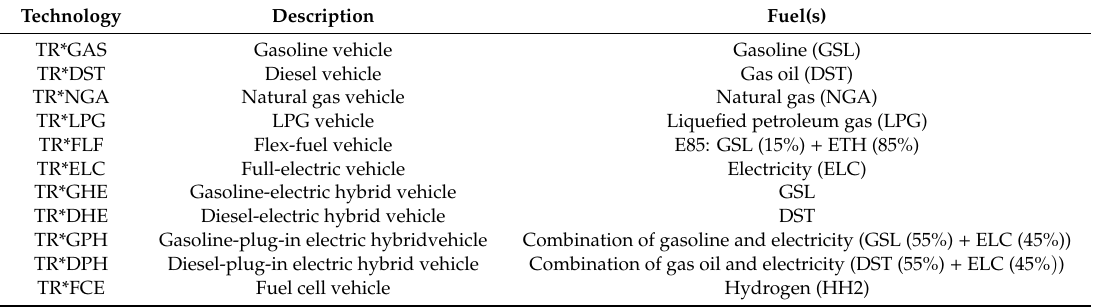
Table 2. Vehicle technologies considered within the EUROFusion TIMES Model (ETM) road transport module; * is a placeholder for the third letter of the codes in Table